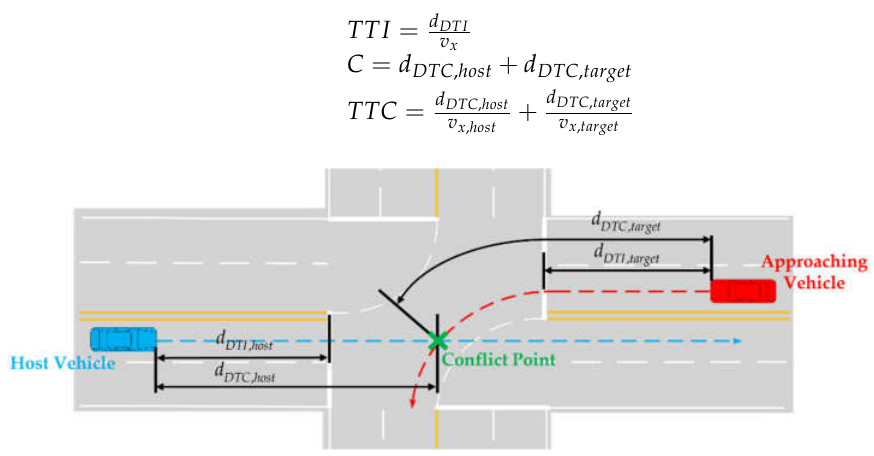
Figure 2. Parameter definition for intersection motion planning.